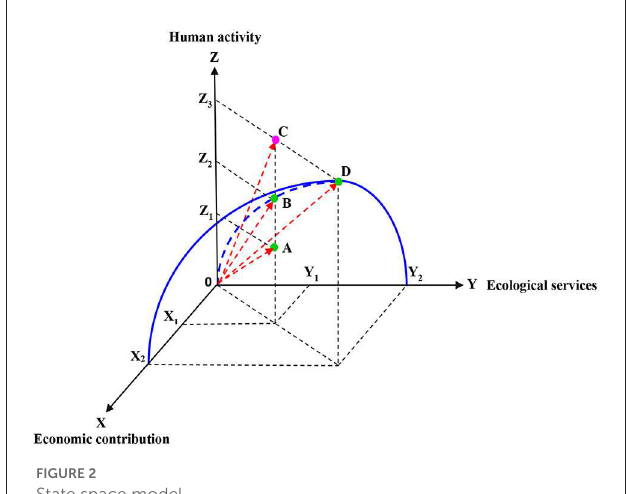
FIGURE2 State space